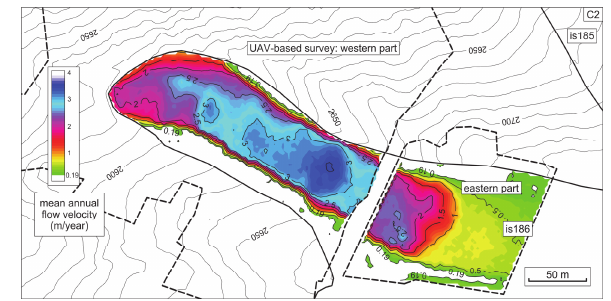
Figure 8. Mean annual horizontal flow velocity 2015-2016